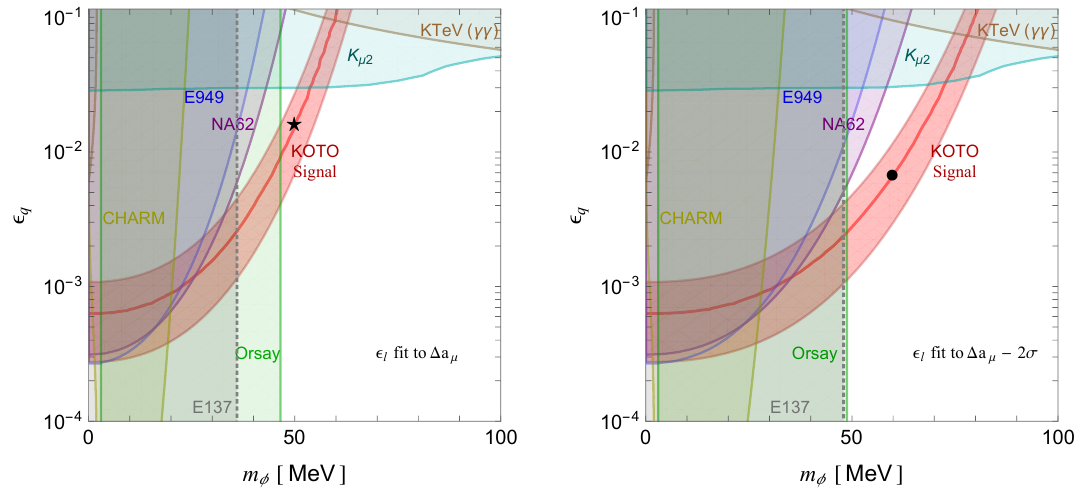
Figure 4 . Left: the parameter space for the e(cid:11)ective model in the m (cid:30) { (cid:15) q plane when (cid:15) ‘ is (cid:12)xed for the central value of (cid:1) a (cid:22) . The red shaded band shows the parameter space where the KOTO signal is achieved at 95% con(cid:12)dential level. Right: the parameter space for the e(cid:11)ective model in the m (cid:30) { (cid:15) q plane when (cid:15) ‘ is (cid:12)xed to (cid:1) a (cid:22) (cid:0) 2 (cid:27) . All the constraints are shown in the same colors as in (cid:12)gure 3.